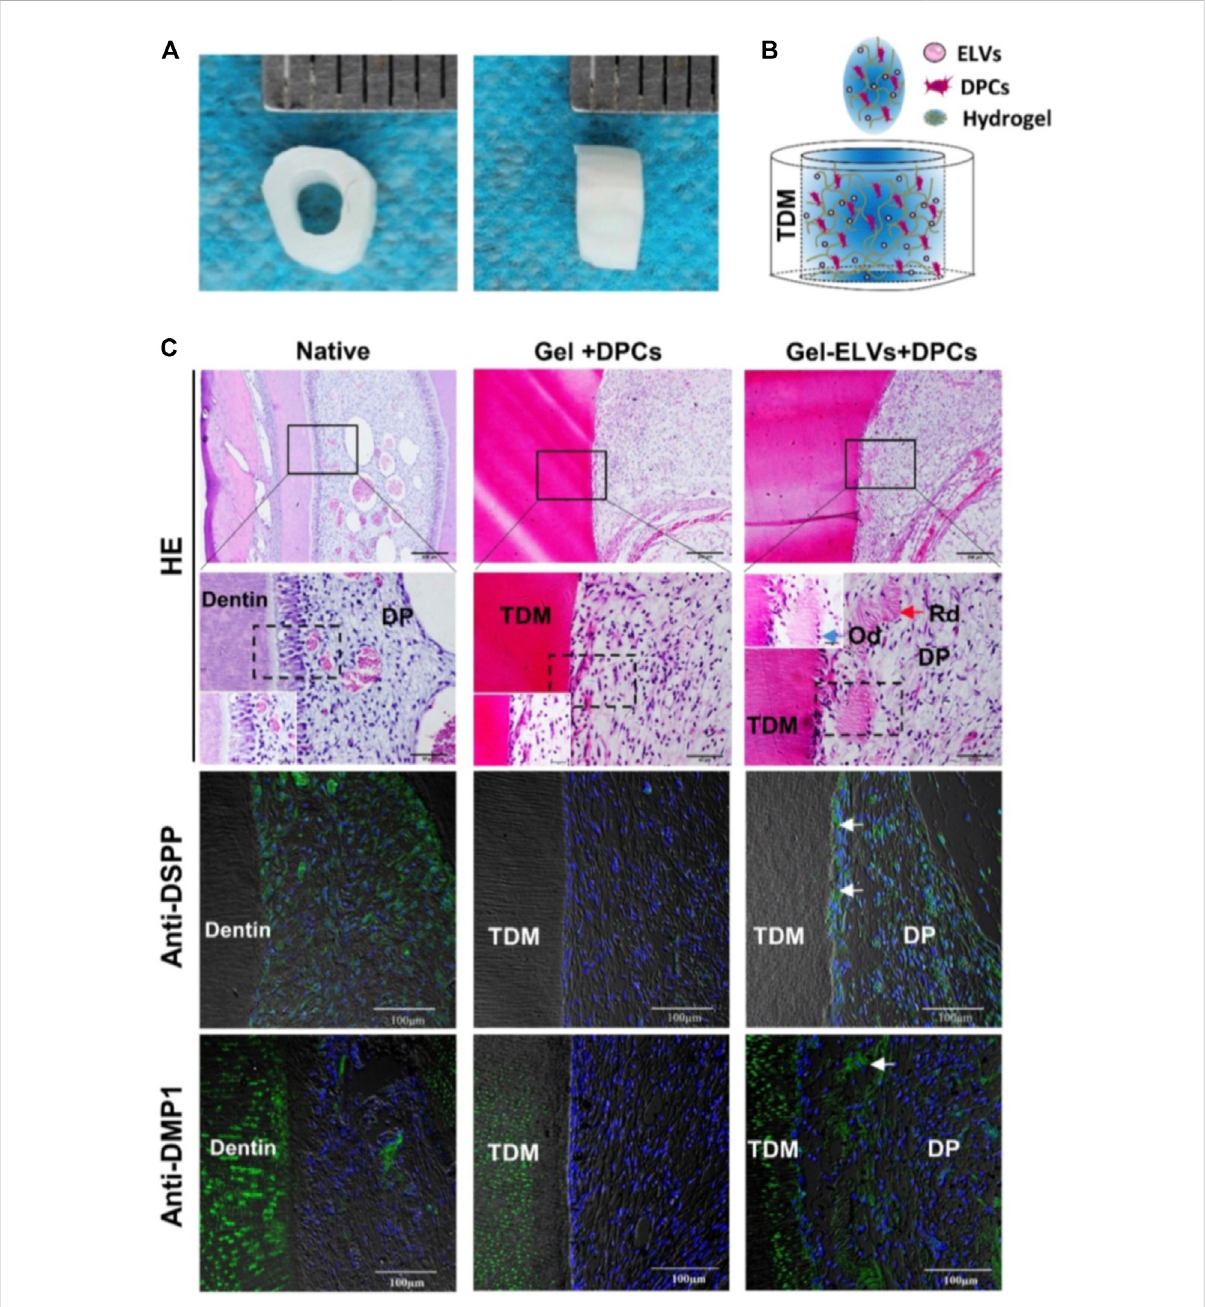
Hertwig ’ s epithelial root sheath cell-derived exosome-like Vesicles (ELVs) accelerate the formation of pulp-detin complexes in vivo . (A) The treateddentinmatrix(TDM)canalobtainedfromextractedincisorsofpigsformedatoothrootslicewithaninternaldiameterof2 mmandaheightof 3 mm. (B) Schematicof the contents of TDM. Exosome-like vesicles were resuspended in DPC cells mixed with collagen hydrogeland then injected into the tooth root slice model. (C) HE staining showing newly regenerated tooth structures (e.g., polarizing odontoblast-like cells and predentin-like tissue) at the interface between the pulp-like tissue and the dentin. Immuno fl uorescence analysis revealing the increased expression of odontogenic differentiation markers (DSPP and DMP1) in the ELV-treated group, with white arrows indicating positive green staining.